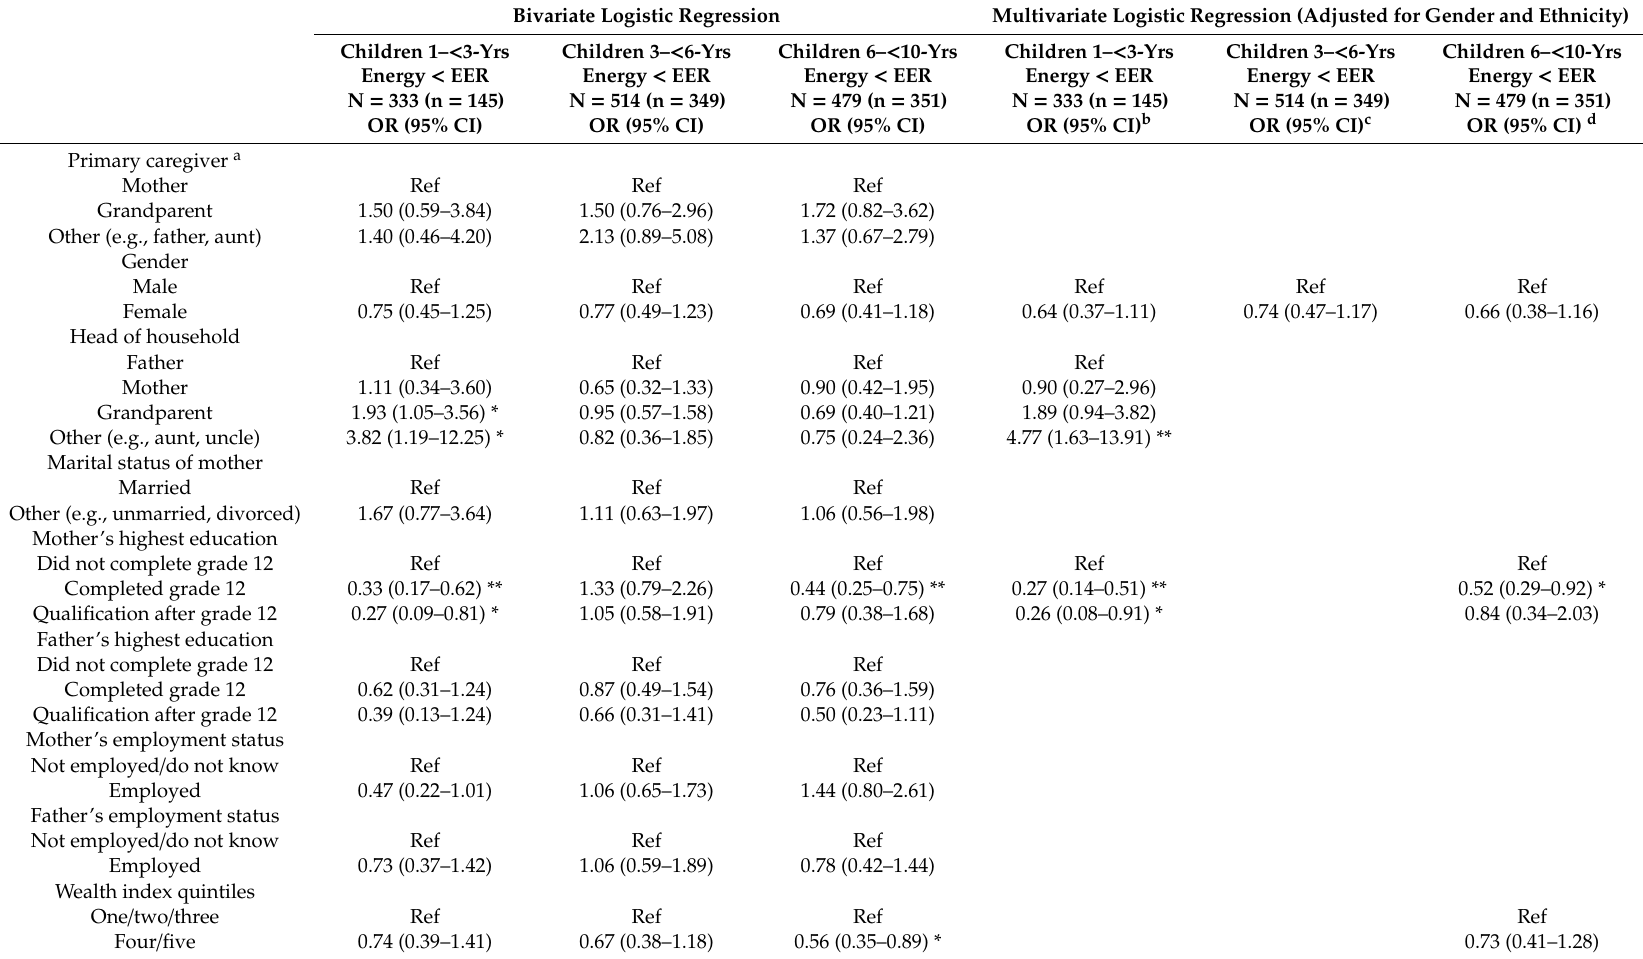
Table 7. Bivariate and multivariate logistic regression of sociodemographic factors on having an energy intake below the estimated energy intake (EER) by age group. Bivariate Logistic Regression Multivariate Logistic Regression (Adjusted for Gender and